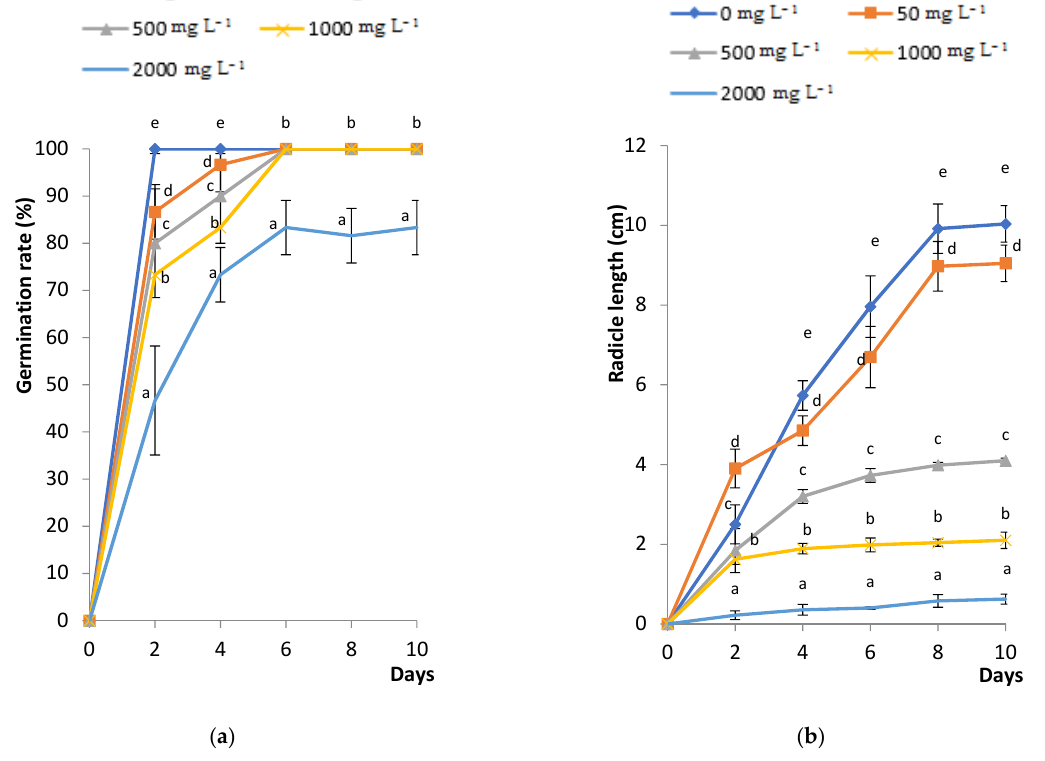
Figure 1. Monitoring of the effects of PbCl 2 treatment (0, 50, 500, 1000 and 2000 mg L − 1 ) on seed germination rate ( a ) and radicle length ( b ) of treated fenugreek seeds over 10 days. All the values are means of three triplicates ± SD of 10 seeds each. ANOVA is significant at p < 0.05. Different letters indicate significantly different values at a particular duration (DMRT, p < 0.05). The amylase activity was measured during 10 days of PbCl 2 treatment at the germi- nation stage (Figure 2). After 2 days of germination in the dark, there were no significant differences recorded in 50, 500 and 1000 mg L − 1 Pb treatment results, except for 2000 mg L − 1 where the amylase activity was significantly decreased to 28 UI g − 1 , compared to 56 UI g − 1 in the control. After 4, 6, 8 and 10 days, the increasing Pb concentrations yielded a significant decrease in the amylase activity, except with 50 mg L − 1 PbCl 2 concentration.